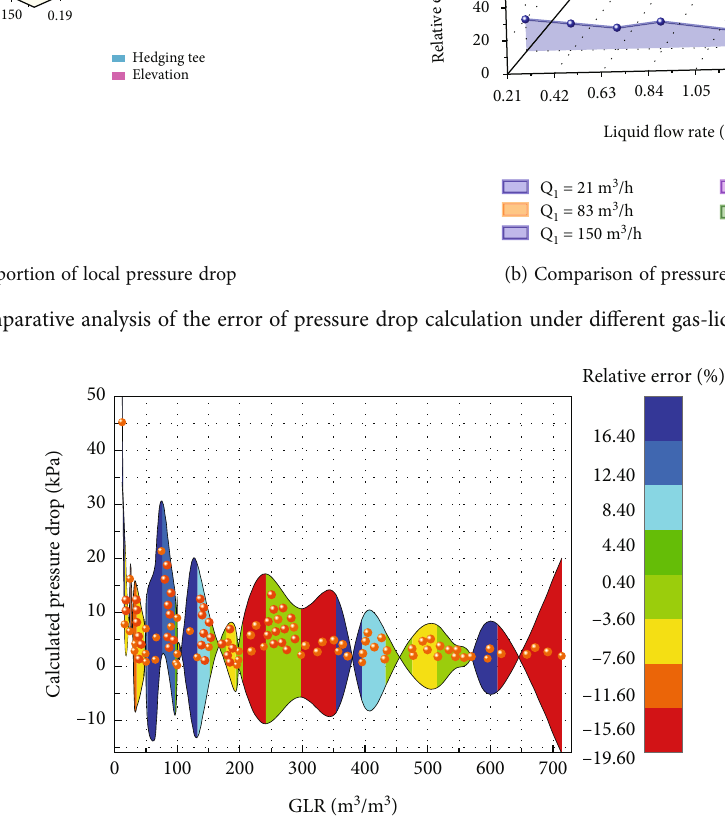
Figure 14: Relative error distribution of pressure drop calculation after